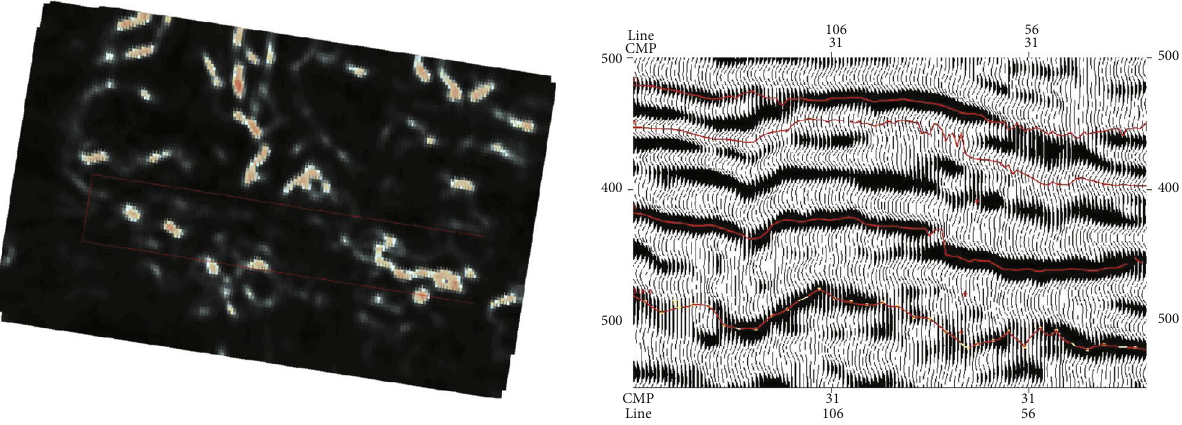
Figure 4: 3D seismic map of working